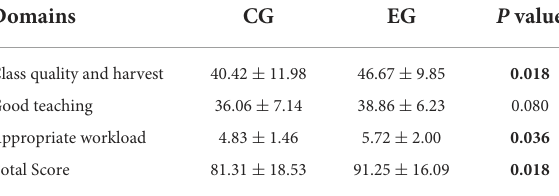
TABLE 5 Comparisons of students’ course experience between two groups after the course (M ±